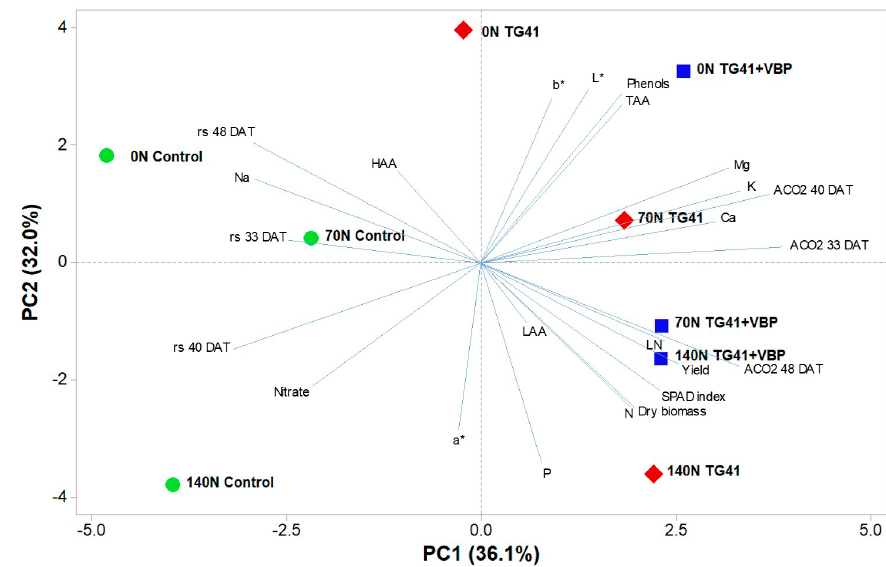
Figure 3. Principal component loading plot and scores of principal component analysis of all morpho-physiological and qualitative parameters analyzed in Romaine lettuce plants submitted to a factorial experiment with three N fertilization levels (0N = 0 kg ha − 1 , 70N = 70 kg ha − 1 , 140N = 140